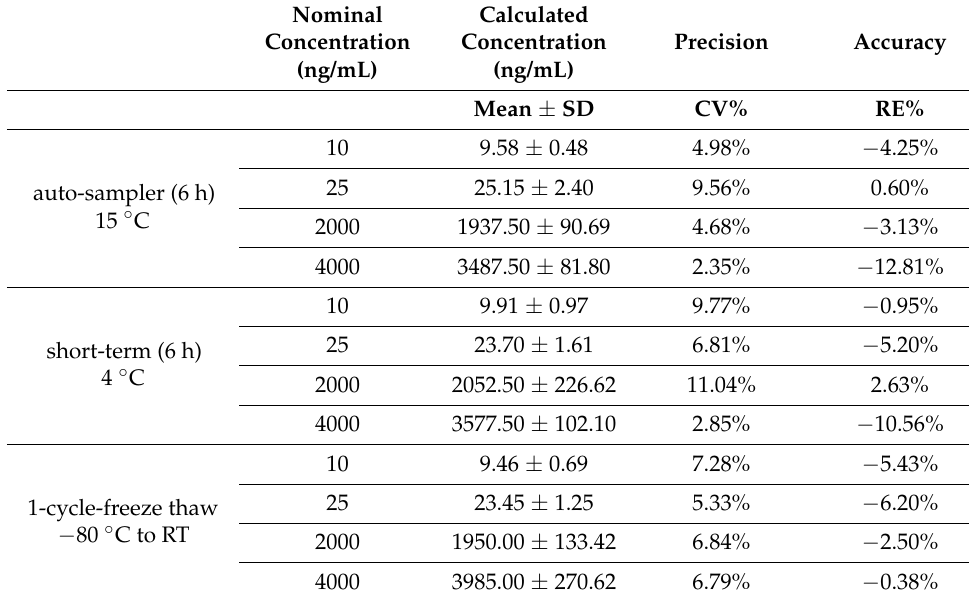
Table 3. Stability data for OXP in rat